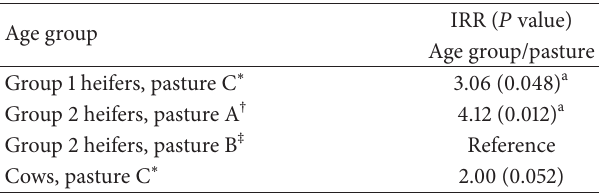
Table 6: Summary of incidence rate ratio (IRR) for three cohorts of California beef cattle followed up for A. marginale infection by age group/pasture exposure, age group, and stage of